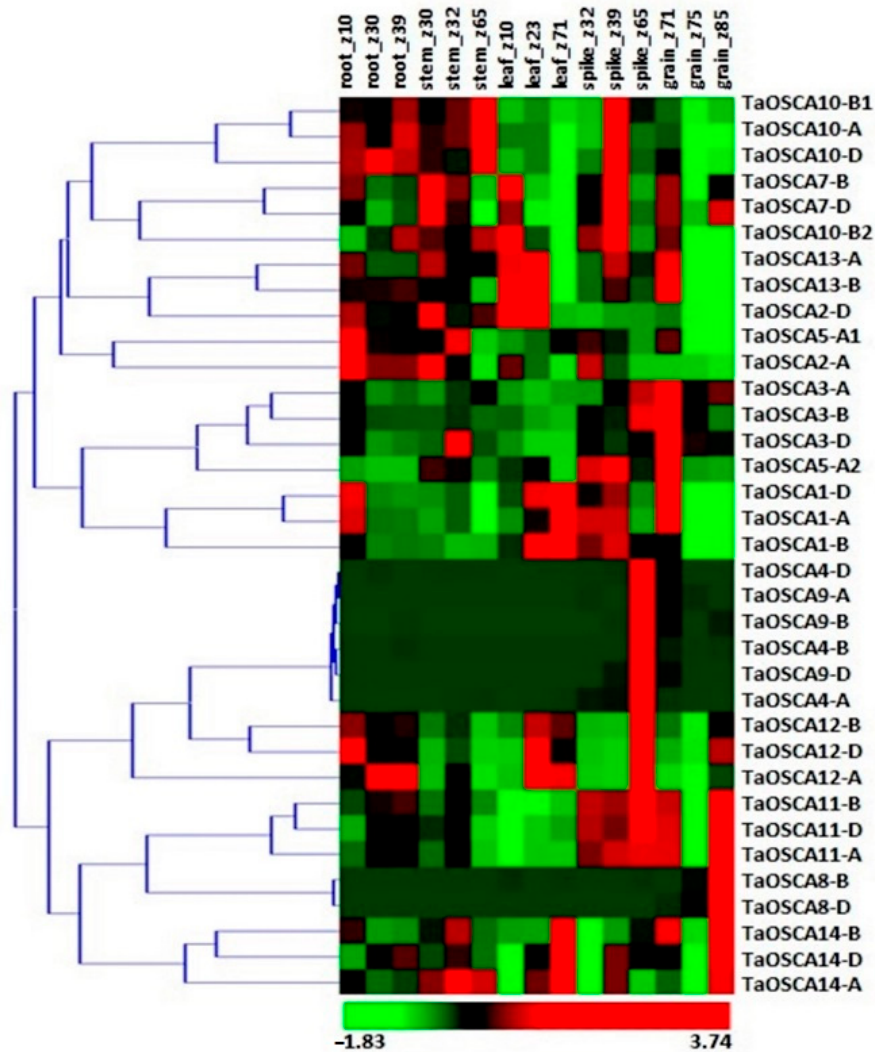
Figure 3. Expression profiling of TaOSCA genes of T. aestivum in various tissue and developmental stages. The heat map shows the clustering and expression profiling of OSCA genes of T. aestivum. The color bar depicts upregulated and downregulated expression with red and green color, respectively.